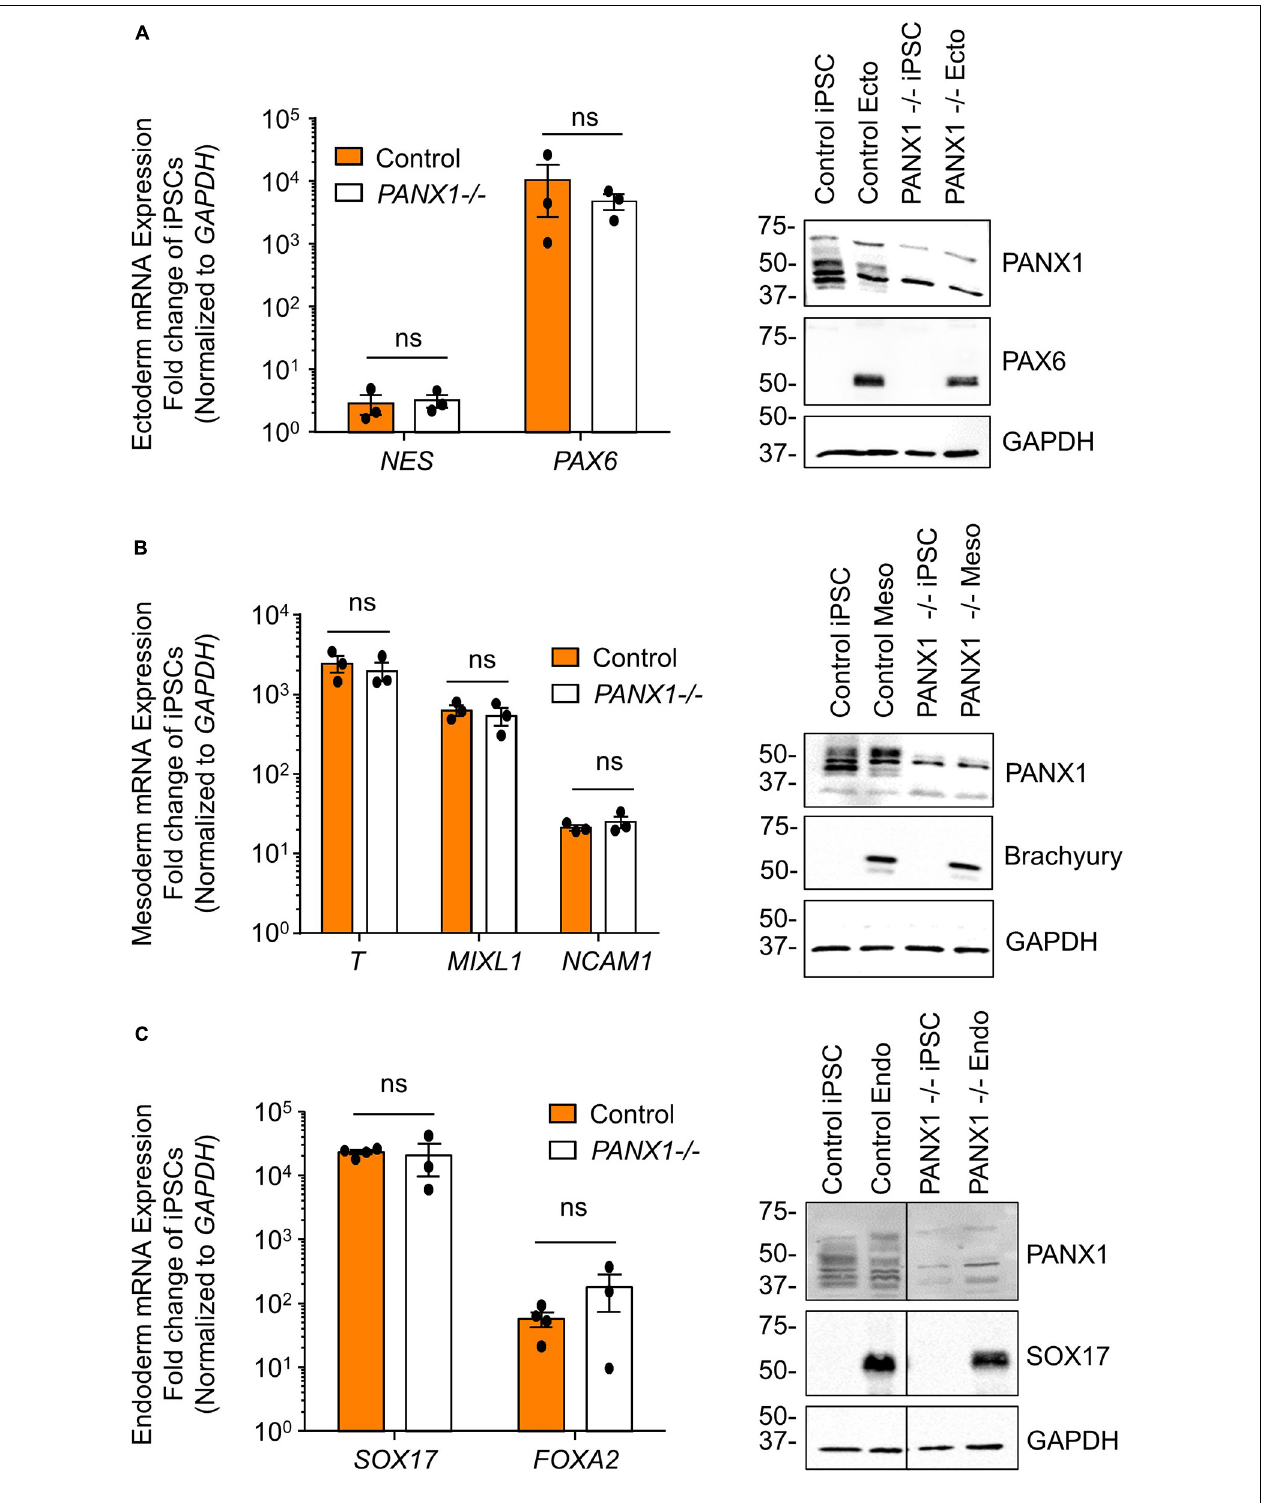
FIGURE 7 | Exogenous pressures override PANX1-/- lineage bias. qPCR gene expression analysis and Western blot of lineage-specific markers after directed differentiation of control and PANX1-/- iPSCs into (A) ectoderm (NES, PAX6), (B) mesoderm (T (Brachyury), MIXL1, NCAM1) and (C) endoderm (SOX17, FOXA2). Data represent the standard error of the mean of 3-4 independent experiments. ns, non-significant compared to control.